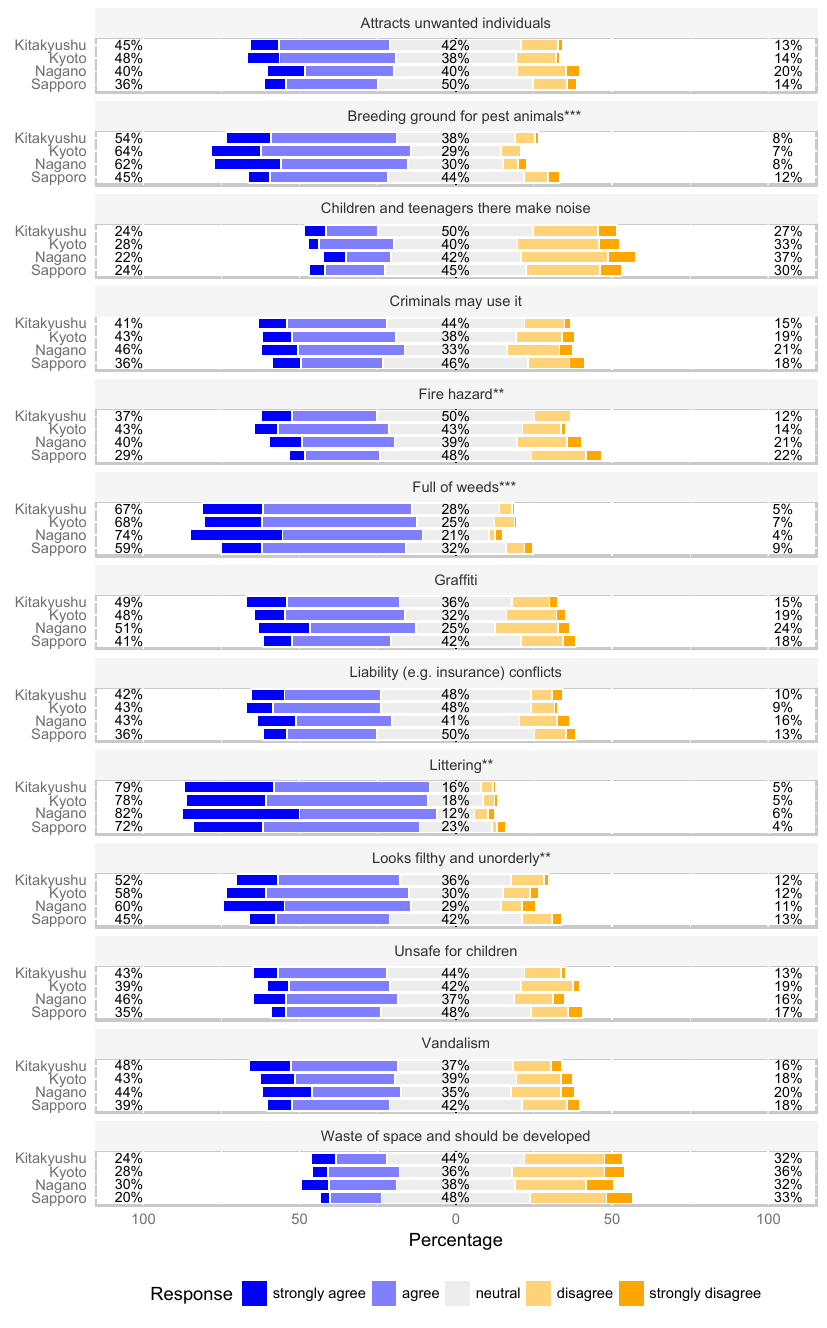
Figure 6. Respondents’ level of agreement to potential IGS problems. Significant differences between the four cities are noted as * ( p < 0.05), ** ( p < 0.01), and *** ( p < 0.001).